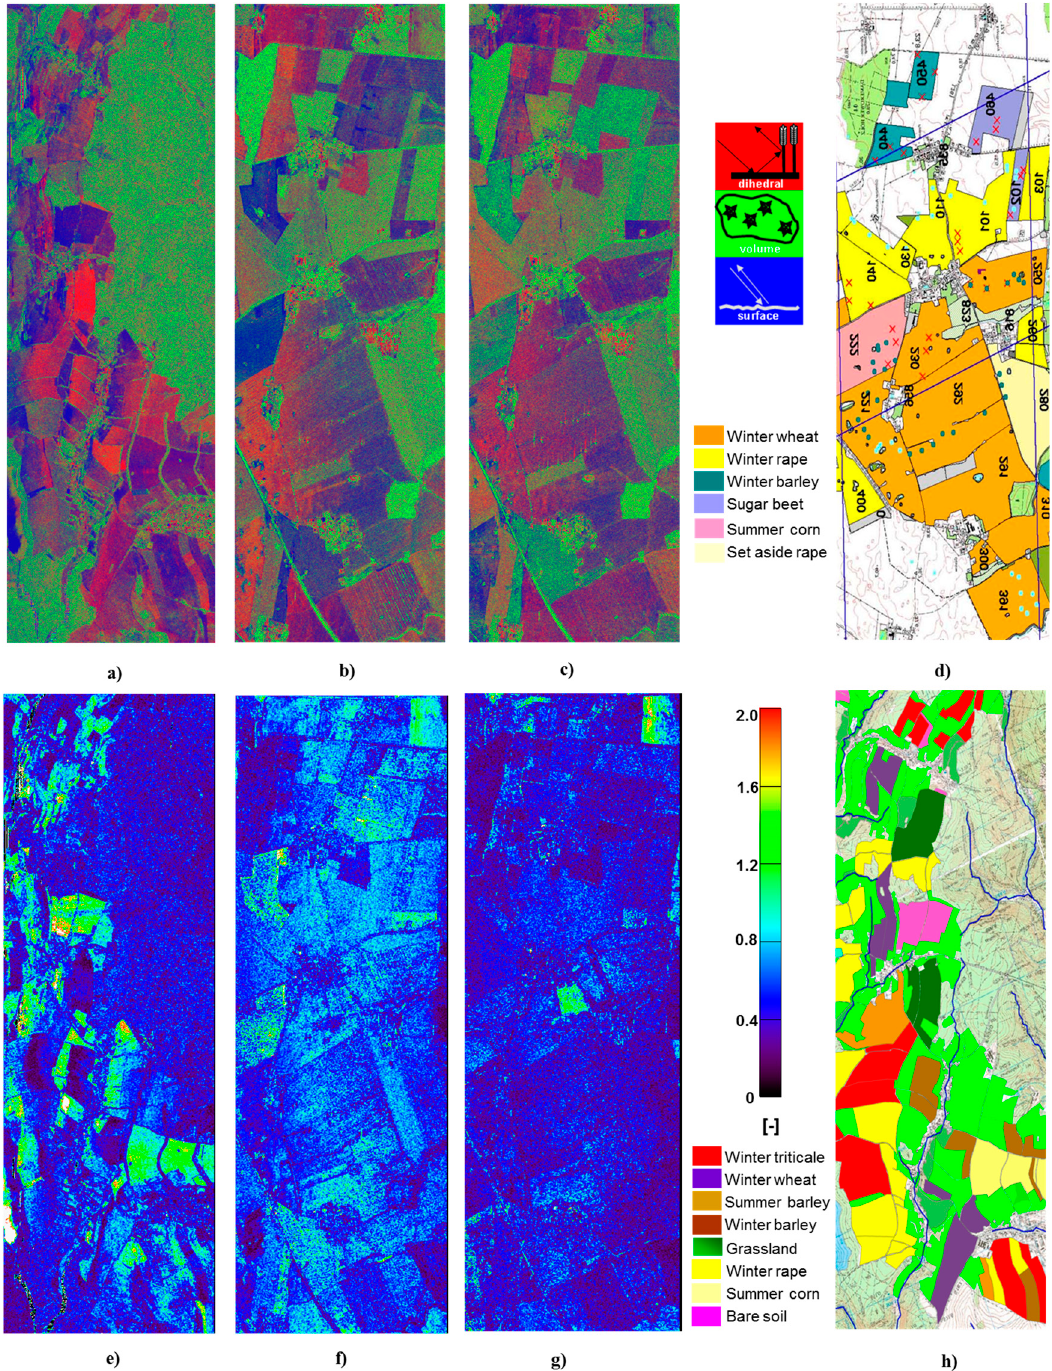
Figure 27. First row: RGB-composite of normalized Pauli decomposition-based scattering components (R: 1/2|S HH − S VV |² even-bounce/dihedral scattering, G: 2|S XX |² volume/vegetation scattering, B: 1/2|S HH + S VV |² odd-bounce/surface scattering) for the May acquisition of the OPAQUE 2007 ( a ), the June acquisition ( b ) and the July acquisition ( c ) of the AgriSAR 2006 campaign; ( d ) the land use of the AgriSAR 2006 campaign; second row: comparison of α XD of the data for the OPAQUE 2007 campaign ( e ) and the AgriSAR campaign ( f ) June acquisition and ( g ) July acquisition); ( h ) the land use of the OPAQUE 2007 campaign.